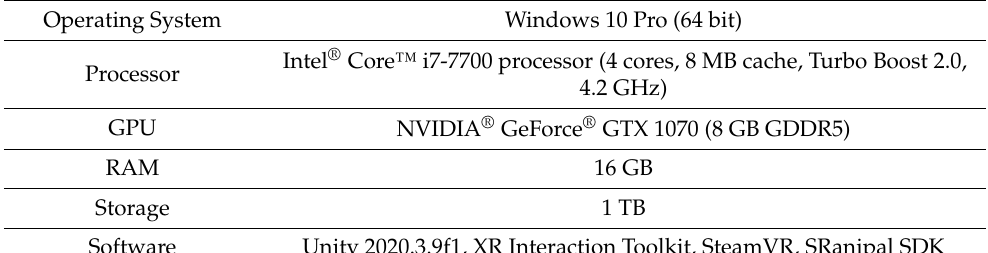
Table 3. Specifications of the computer used in the